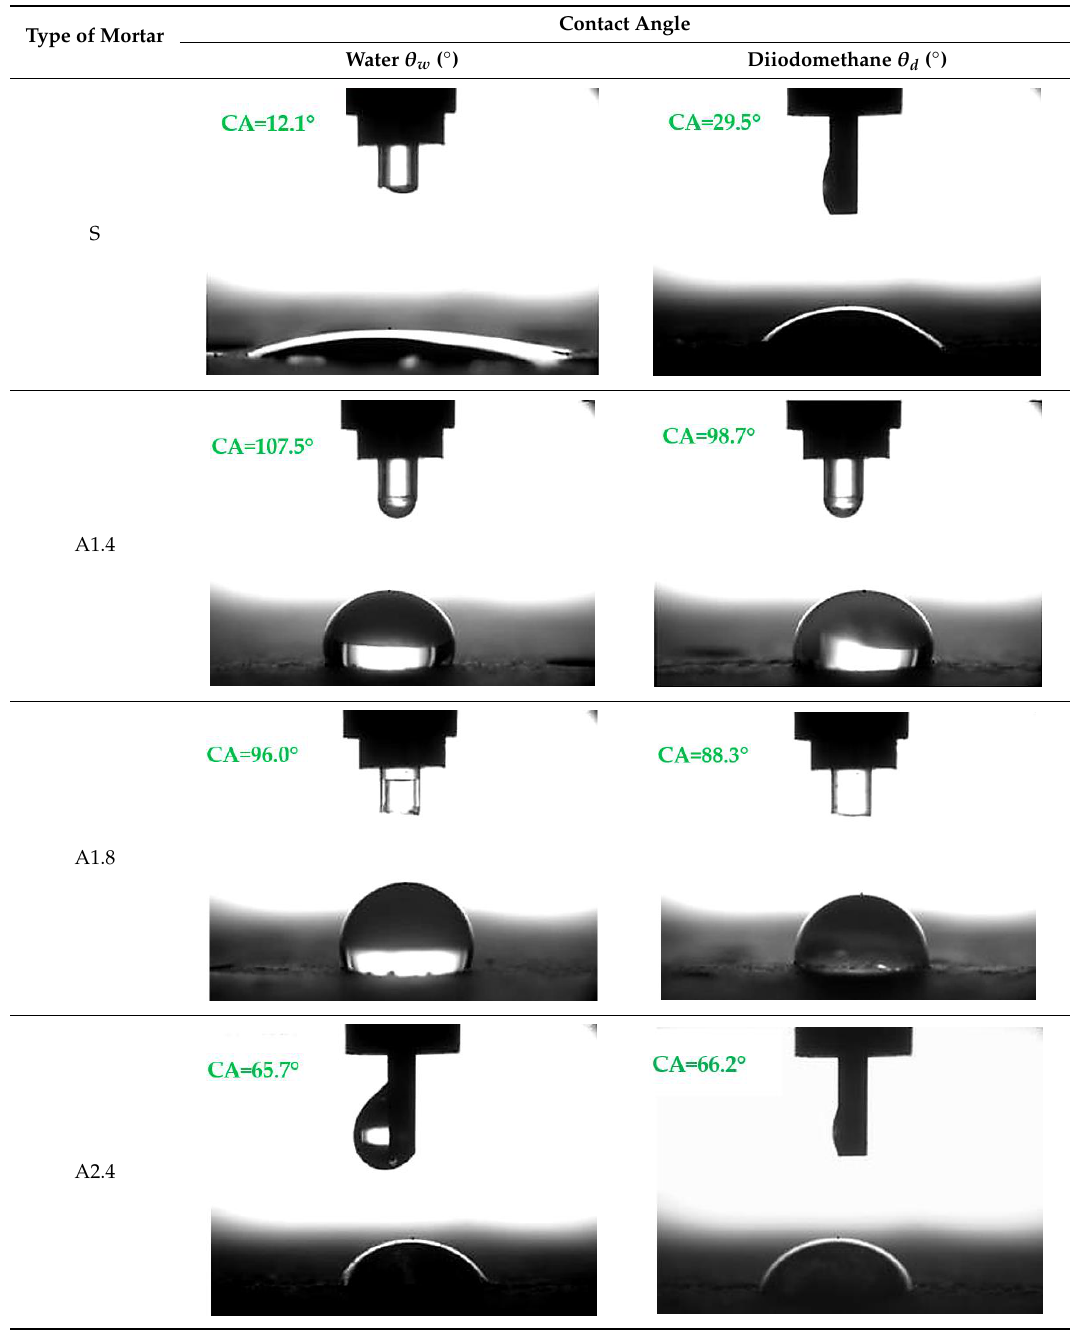
Table 7. Angles of liquids of standard and hydrophobized mortars.